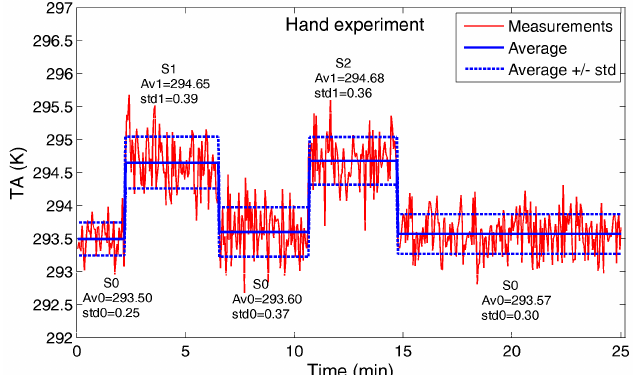
Figure 8. Hand experiment: antenna temperature T A measured by the radiometer. For each setting (S0, S1 and S2), average (AvN) and standard deviation (stdN) are reported in Kelvin.